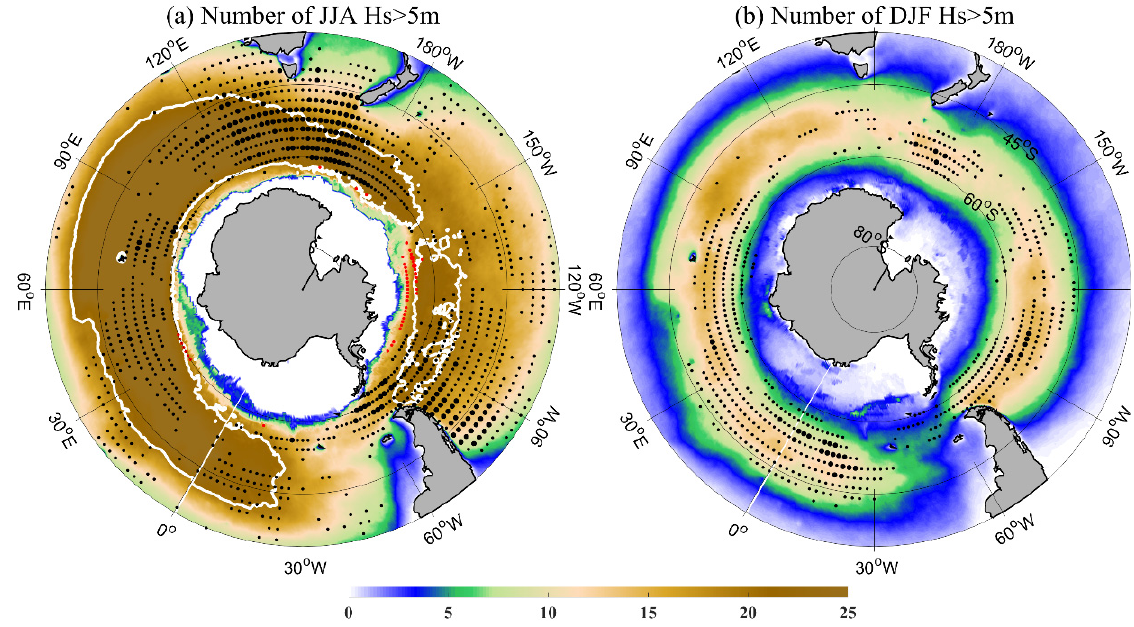
Figure 4. Similar to Figure 2, but for the number of wave processes larger than 5 m. The white contours show where the number was more than 15, the small black dots indicate where the trend was higher than 0.1 /a and less than 0.2 /a, the larger black dots show where the trend was larger than 0.2 /a, and the red dots indicate a decreasing trend with the criteria similar to those of the black dots.